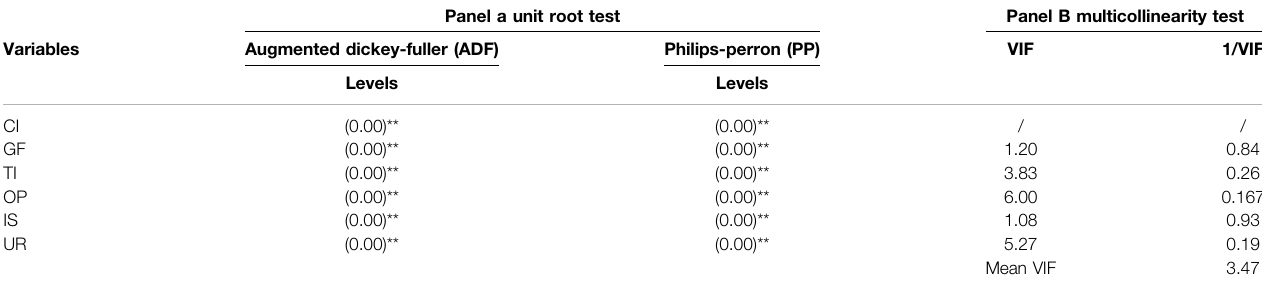
TABLE 6 | Results of unit root test and multicollinearity